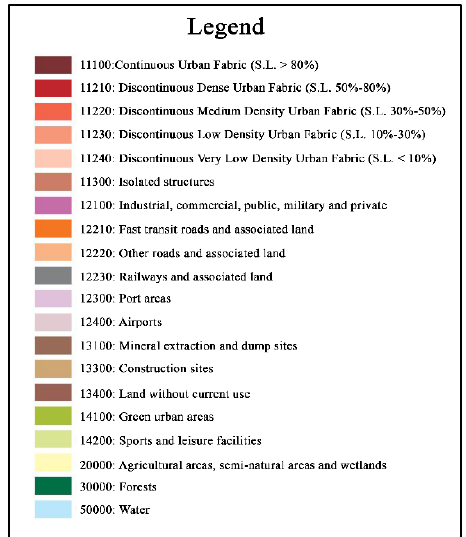
Figure 2. Urban Atlas Land use/cover classes used in the